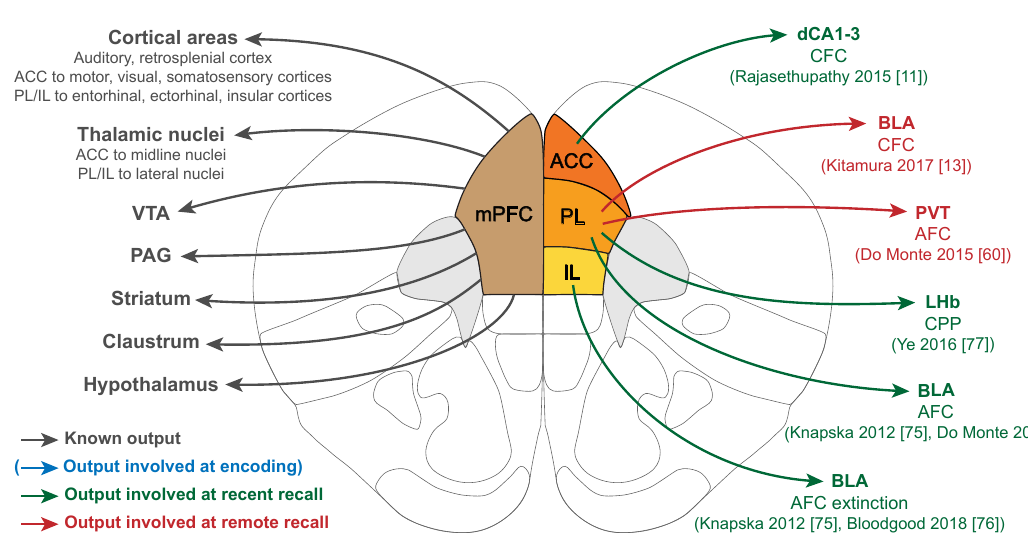
Figure 2. mPFC outputs are involved in recalling fear memories. Left: Anatomically defined outputs from the mPFC. Right: mPFC outputs functionally involved during fear memory consolidation, color coded by the phase of the memory (blue: encoding, green: recent recall, red: remote recall). Note the absence of functionally characterized mPFC outputs at the time of encoding. AFC: Auditory fear conditioning; CFC: Contextual fear conditioning; CPP: Conditioned place preference; BLA: Basolateral amygdala; LHb: Lateral habenula; PAG: Periaqueductal gray; PVT: Paraventricular thalamus; VTA: Ventral tegmental area.